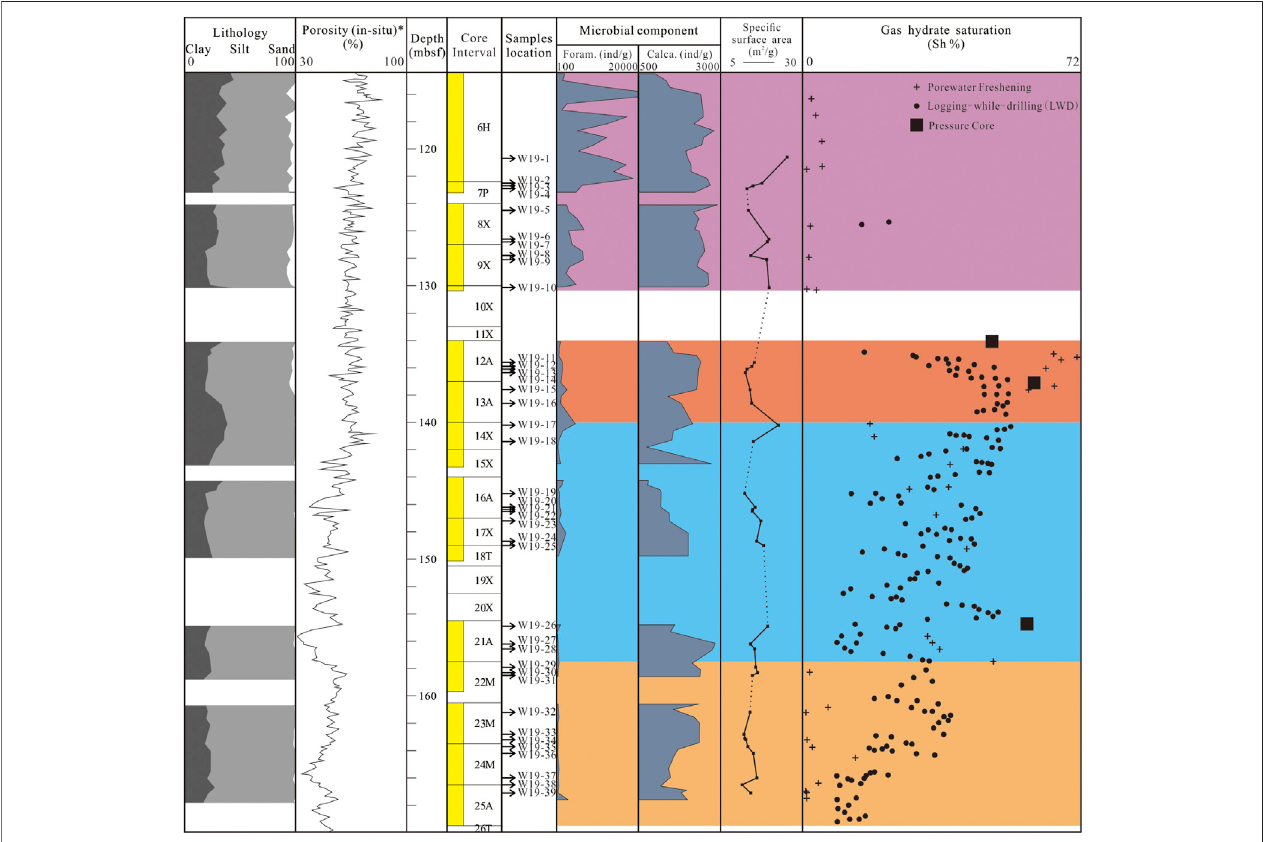
FIGURE 3 | The comprehensive column of Site W19. The lithology data are cited from voyage report of the GMGS3. Foram. and Calca. are short for foraminifera andcalcareousultra-microfossils,respectively.Thepurple,red,buleandorangeshadedareaindicatenon-GH, Ⅰ -, Ⅱ -,and Ⅲ -GHRlayers,respectively.*ThePorosity( in- situ ) is calculated by LWD